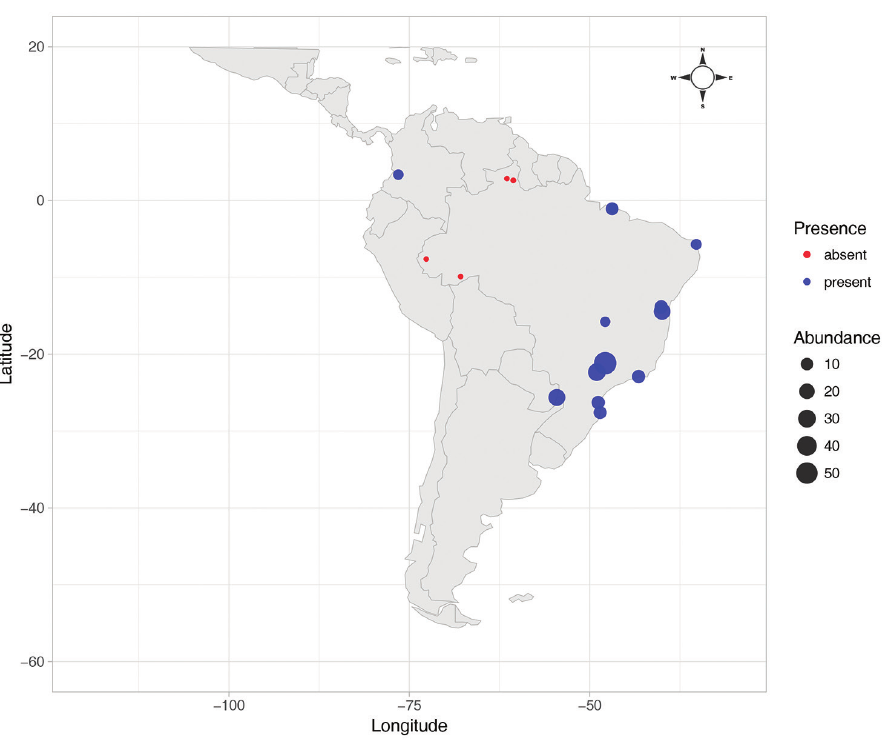
Figure 1. Sycobia hodites Farache & Rasplus, sp. n., Sampling. Blue circles represent abundances where the species was sampled, whereas red circles represents localities where F. benjamina was sampled but no evidence of galls were found. Made with natural earth